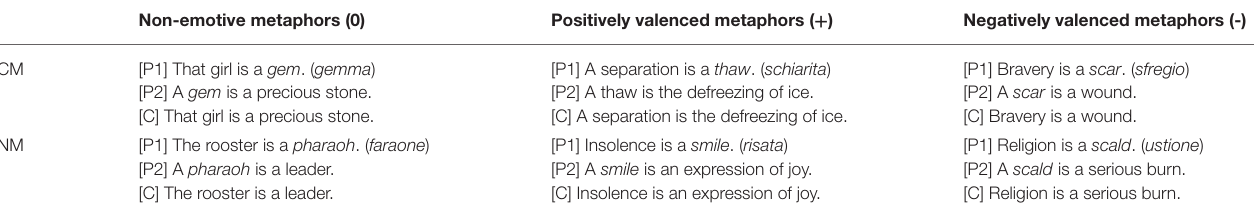
TABLE 7 | Examples of arguments in English for each middle term condition (Experiment 2).